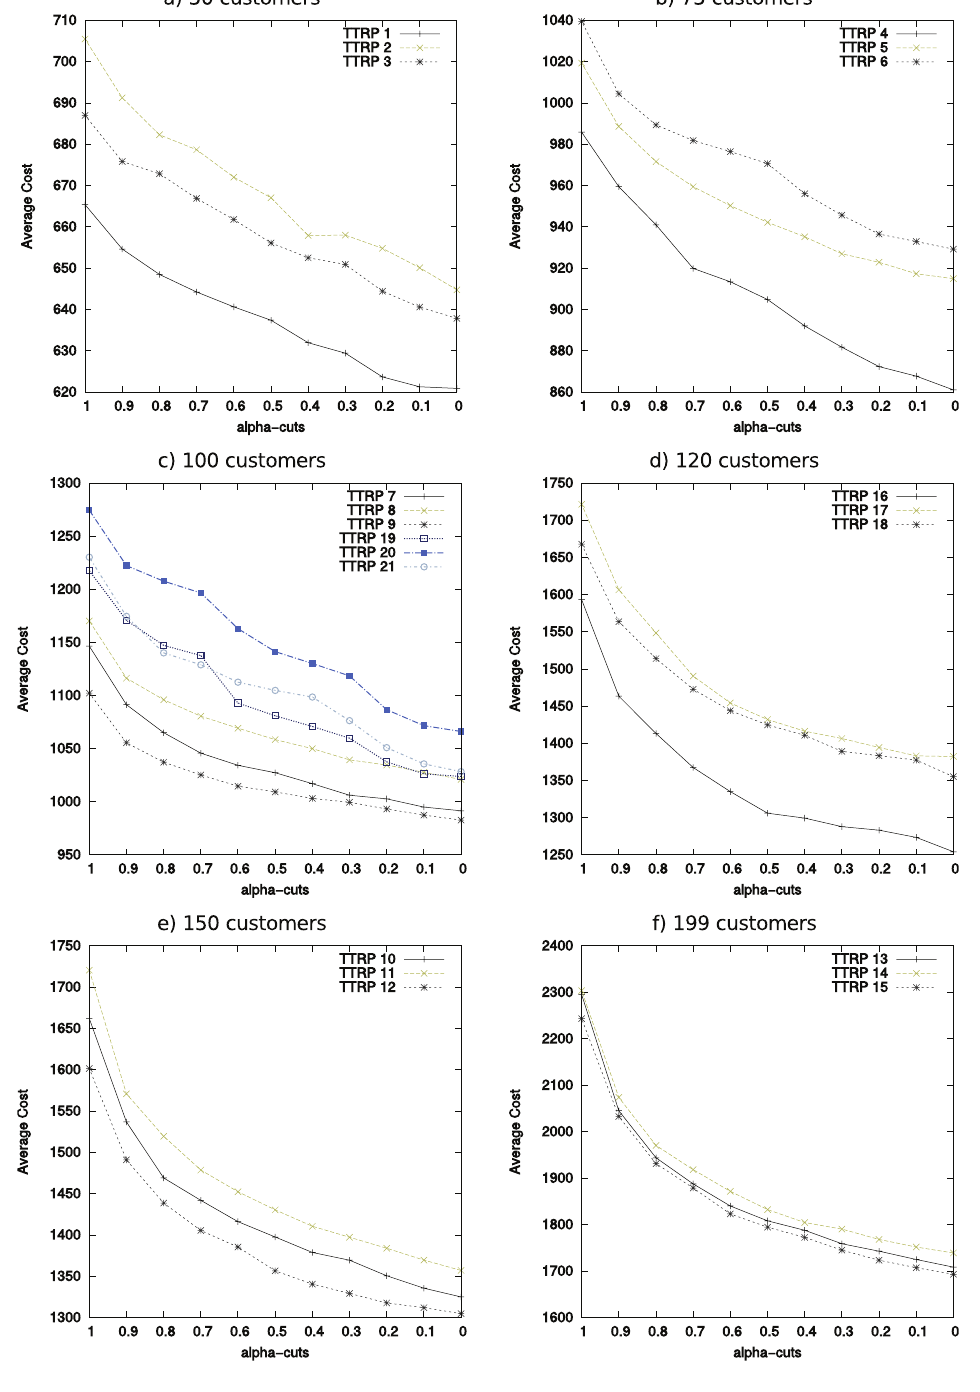
Figure 2: Behavior average of the